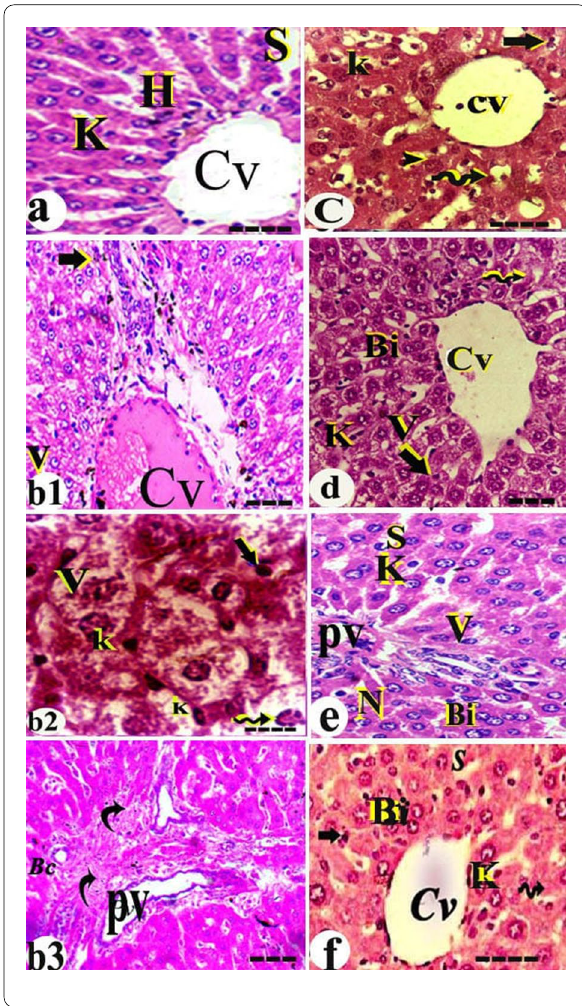
Fig. 5 Photomicrograph of hematoxylin and eosin stained liver section from a : control group showing normal central vein (CV) in the middle, hepatocytes (H), adjacent sinusoids (S) which contain Kupffer (K) cell. b1: DMBA‑treated group showing congested central vein (CV), severe degeneration in hepatocytes with vacuolated cytoplasm (V) and pyknotic nuclei (arrow). b2: Showing severe vacuolated cytoplasm (V), severe degenerated hepatocytes, pyknotic (black arrow) karyorrhexes (zigzag arrow), darkly stained Kupffer cells (K). b3 : Showing portal vein (PV) with thickened wall surrounded by fibrosis (curved arrows) and proliferated bile ductules (Bc). c: DMBA Art‑treated group showing dilated central + vein (Cv), blood sinusoids containing dark staining Kupffer (K), some hepatocytes with pyknotic nuclei (black arrow), karyorrhexes (zigzag arrows) and other hepatocytes with karyomegaly (arrow heads). d: DMBA Ech‑treated group showing liver cells with + few cytoplasmic vacuolation (V), few hepatocytes appeared with pyknotic nuclei (black arrow) or karyolyzed (zigzag arrows) and hypertrophied Kupffer (K) cells. Some binucleated nuclei (Bi) were seen. e: Art DMBA‑treated group showing some improvements in + histological architecture of hepatocytes with nearly normal nuclei (N) and others with binucleated nuclei (Bi), normal portal vein (pv), blood sinusoids (S) and Kupffer (K) cell with few cytoplasmic vacuolations (V). f: DMBA Ech‑treated group showing nearly + normal histological architecture of hepatocytes with normal central (Cv) and hypertrophied Kupffer cells (K) in blood sinusoids (S) except few pyknotic nuclei (black arrow) and some karyolized nuclei (zigzag arrow) and binucleated (Bi) hepatocytes (Hematoxylin and Eosin, Scale bar 20 =